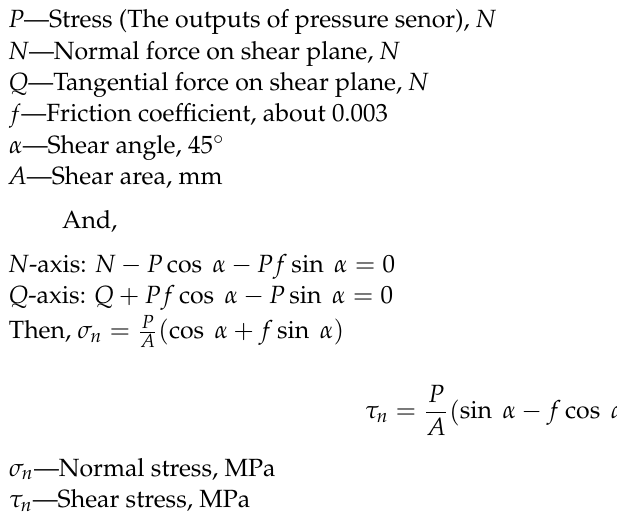
Figure 7. The results of the oblique shear tests. Comparing the AC-20C and AC-13C asphalt samples, it can be seen that the ultimate oblique shear strengths of the AC-20C asphalt samples are almost the same as those of the AC-13C asphalt samples. In the oblique shear test, with the generation and increase of normal stress, the effect of the asphalt mixture gradation on interlayer shear strength de- creases. The AC-20C and AC-13C samples had a tendency to behave the same as would a granular material. Comparing the direct shear curves and the oblique shear curves, it can be seen that the direct shear curves show vibration when the shear displacements reach 1–2 mm, de- noted by point “A”. It is believed that the direct shear strength is mainly provided by